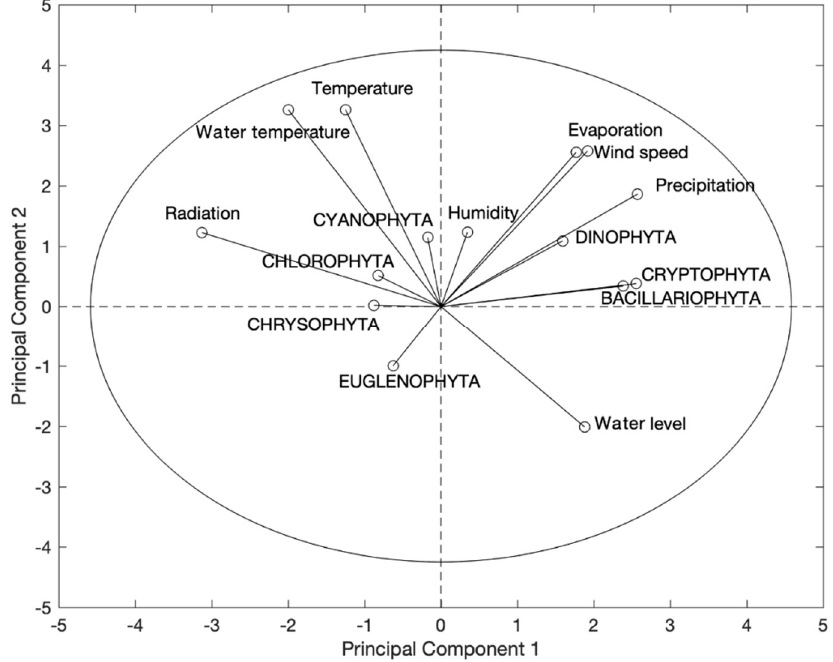
Figure 12. The principal components obtained from the PCA analysis of sets A (phytoplankton) and E (meteorological).